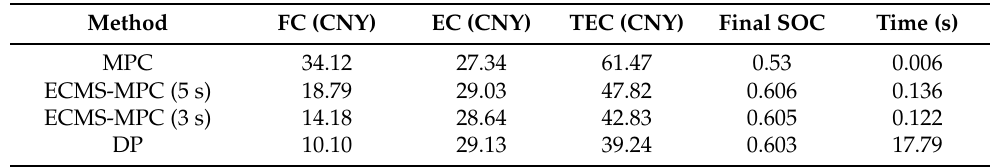
Table 3. Results of different controllers in the NYCC.